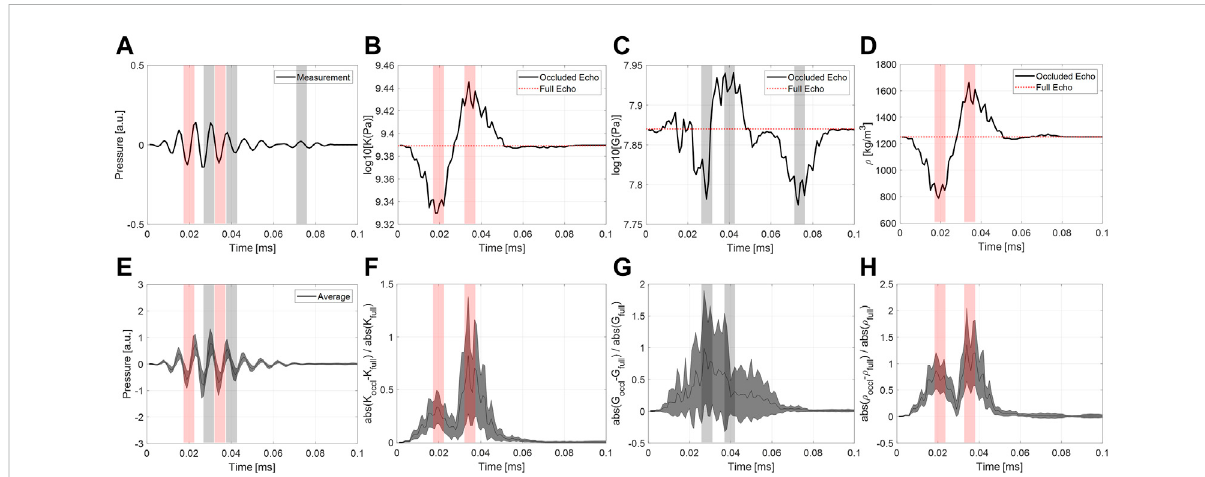
FIGURE 5 Measured echo (A) and the average of the normalized echoes in the test set (E) . Prediction change in bulk modulus (B,F) , shear modulus (C,G) , and mass density (D,H) when input echoes were occluded with sliding time window. The top row illustrates the output material parameters by occluding the measured echo, where the case of no occlusion is plotted with red dotted line. The bottom row illustrates normalized variation of the output parameters where the dotted lines illustrate the mean from the test set and the shaded regions illustrate ± one standard deviation regions. Regions that are most sensitive to changes are highlighted with a vertical